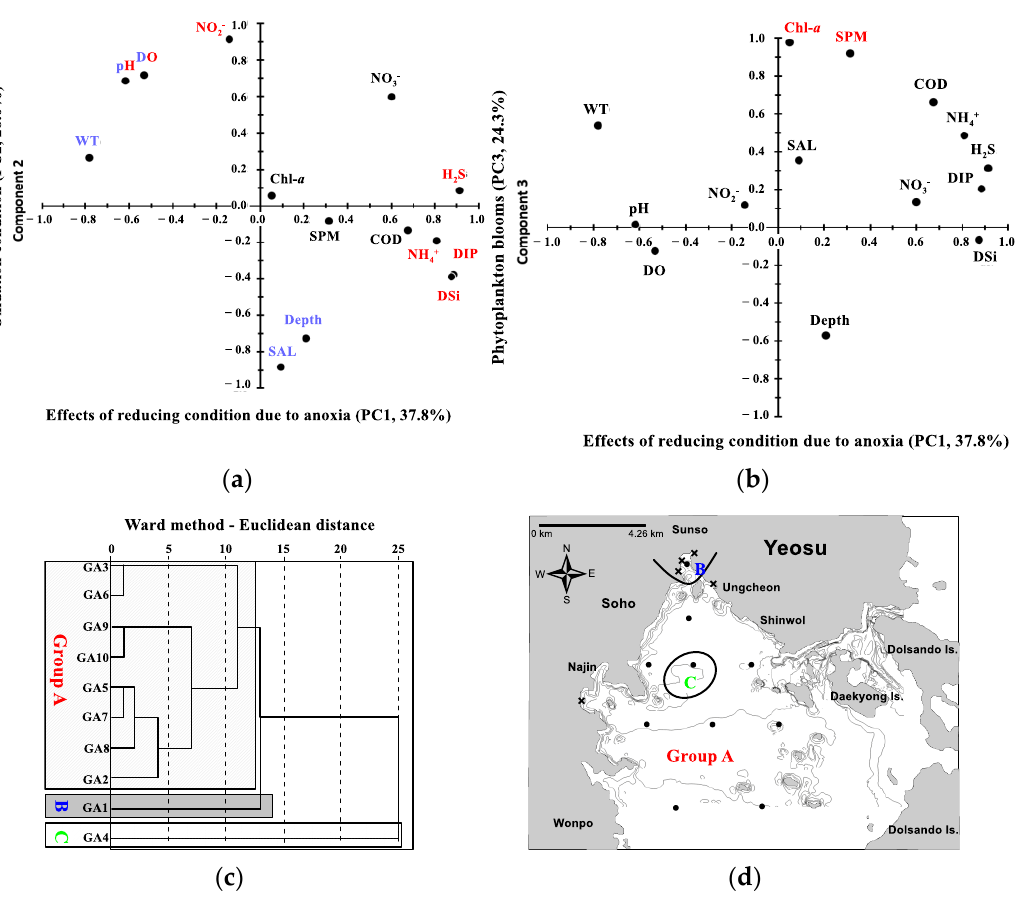
Figure 6. The results of principal component analysis (PCA) and cluster analysis using 14 bottom seawater quality parameters: ( a ) loading plot with PC1 and PC2; ( b ) loading plot with PC1 and PC2; ( c ) classification of the sampling points into three groups based on cluster analysis; ( d ) Groups A, B, and C are illustrated in the sampling area.